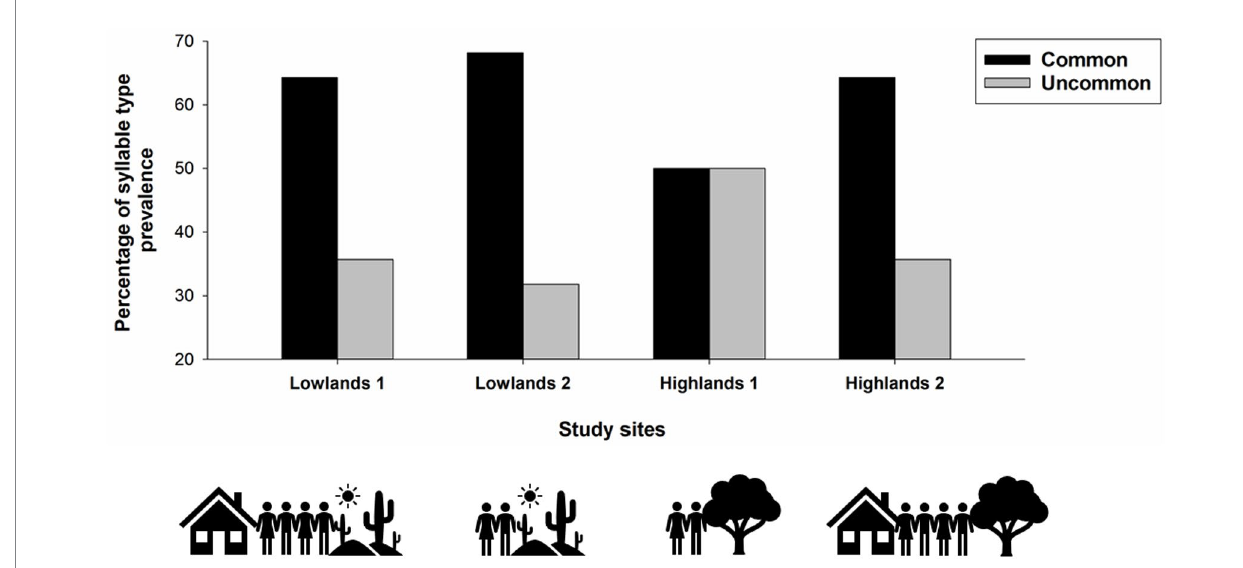
FIGURE 3 Prevalence of syllable types (common, uncommon) across study sites (Lowlands1, Lowlands 2, Highlands 1, Highlands 2). Small ground finches in our study sang IX different syllable types and syllable type was defined as “common” (types IV, V, and VI) or “uncommon” (types I, II, III, VII, IIX, IX) based on